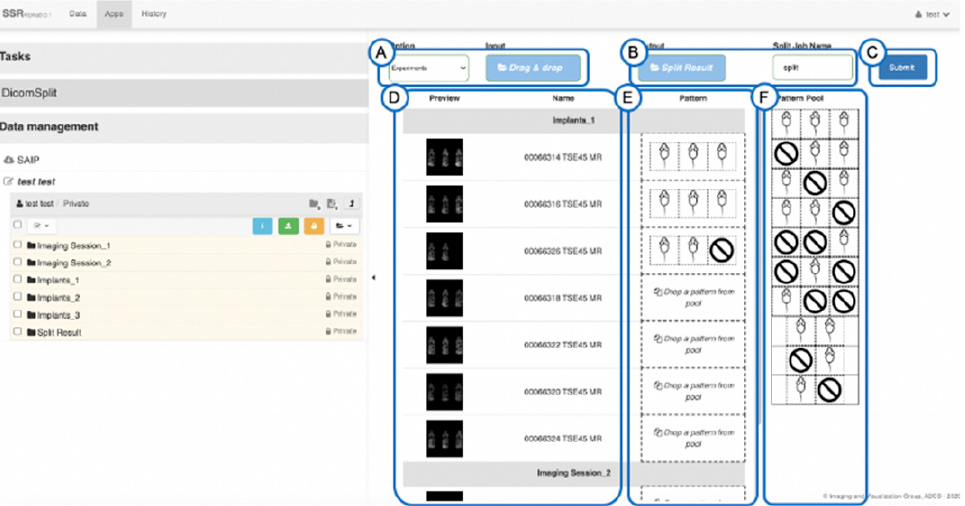
Figure 2. DICOM Split Task GUI. ( A ) Mode selection: allows the user to choose data root folder, either multiple or a single image, ( B ) select Output location, ( C ) Execute the split task in the background, ( D ) Overview panel displays image thumbnails of user-selected datasets. ( E ) Split Patterns selected by users for each dataset. ( F ). The Split Pattern for predefined mice arrangements. The predefined split patterns are drag-dropped from panel ( F ) to ( E